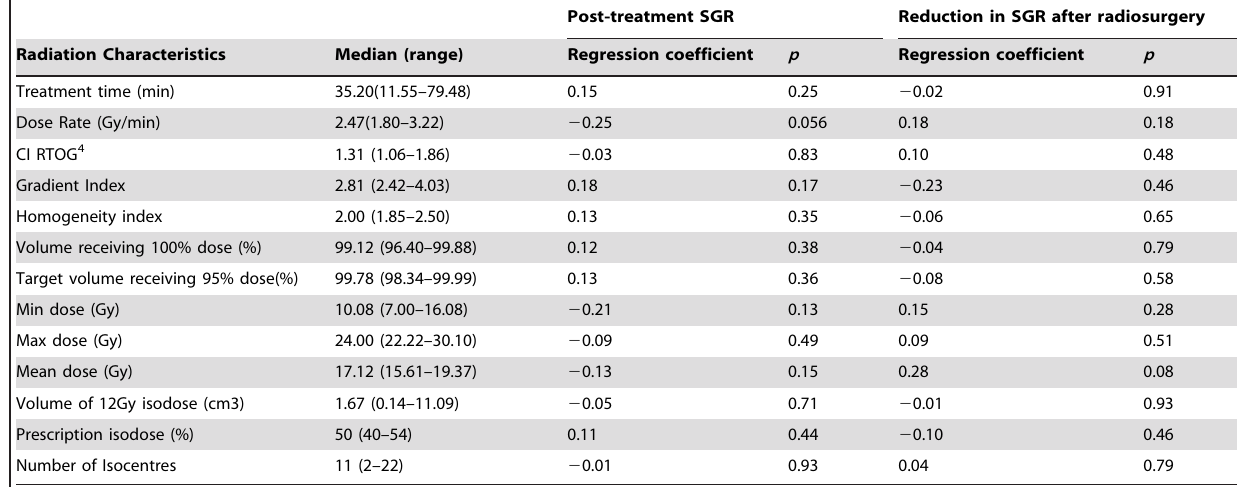
Table 1. Analysis Variables and Univariate